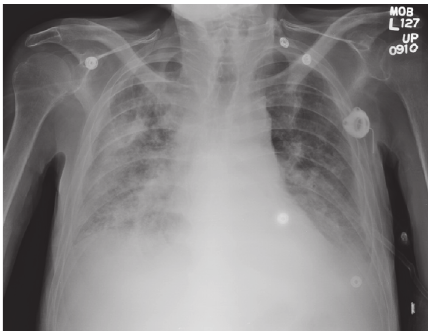
Figure 1: Chest X-ray showing diffuse consolidation throughout the right lung.